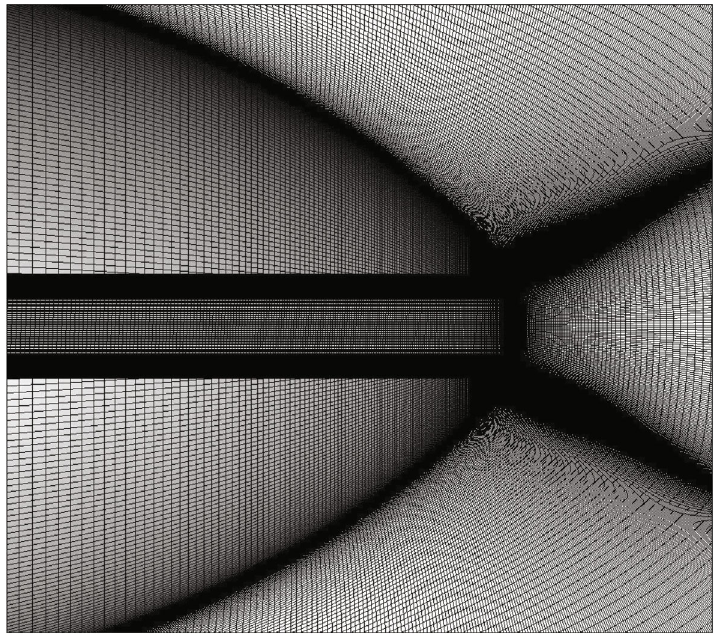
Figure 12: Structured mesh distribution over the wall of the pitot-static